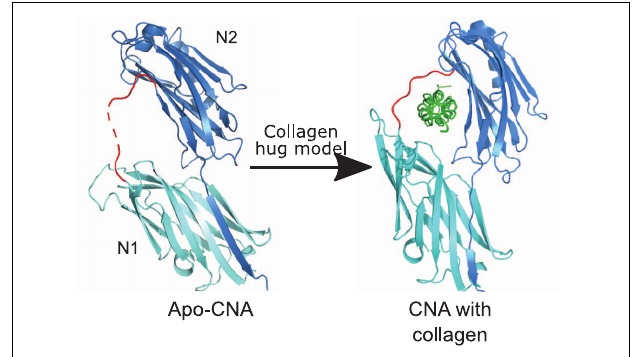
FIGURE 2 | Collagen hug model. The N1N2 domains of CNA in both apo-form [PDB code: 2F68 (Zong et al., 2005)] and with collagen peptide [PDB code: 2F6A (Zong et al., 2005)] are shown. N2 and N1 domains are shown in dark blue and light teal color, respectively. CNA N1N2 domains are connected together by a linker shown in red. Collagen triple helix is shown in green. C-terminal extension of the N2 domain that forms a latch is shown as dark blue β -strand in N1